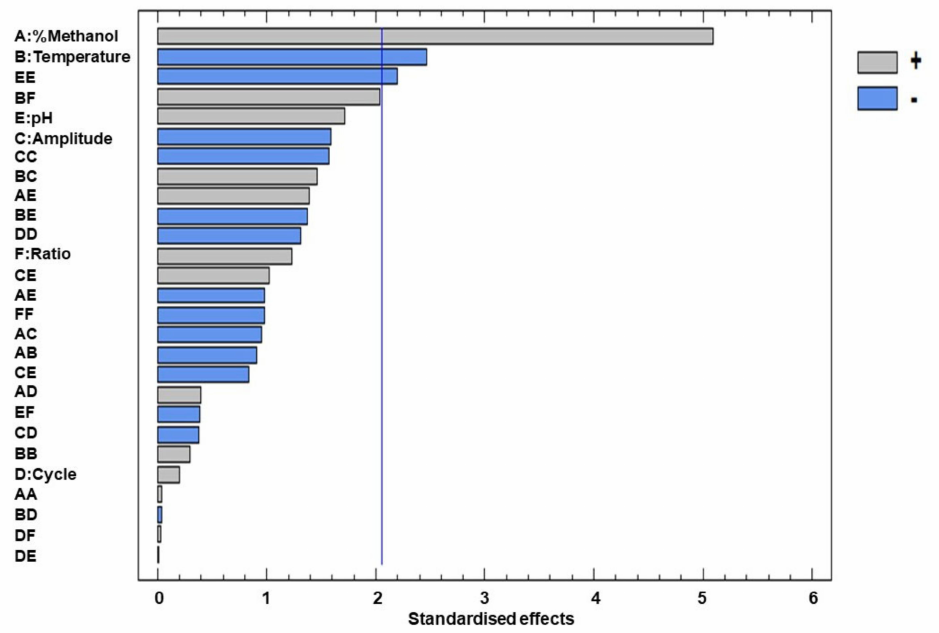
Figure 2. Pareto chart of the standardised effects of the total flavonoids. Considering the data obtained from the Pareto chart and from the ANOVA, the following factors and/or interactions can be considered relevant for this study: % methanol in water, extraction temperature and the quadratic interaction of pH. Among the linear terms, the most significant factor was the percentage of methanol in water since this factor had a positive effect on the response (2.551), which means that a high percentage of methanol in water within the studied range is more efficient for the extraction of the flavonoids. This variable was followed by temperature, which had a negative significant effect ( − 1.233), which means that, at lower temperatures, a higher content of flavonoids is obtained, and, finally, by the quadratic interaction of pH, which had a negative significant effect ( −